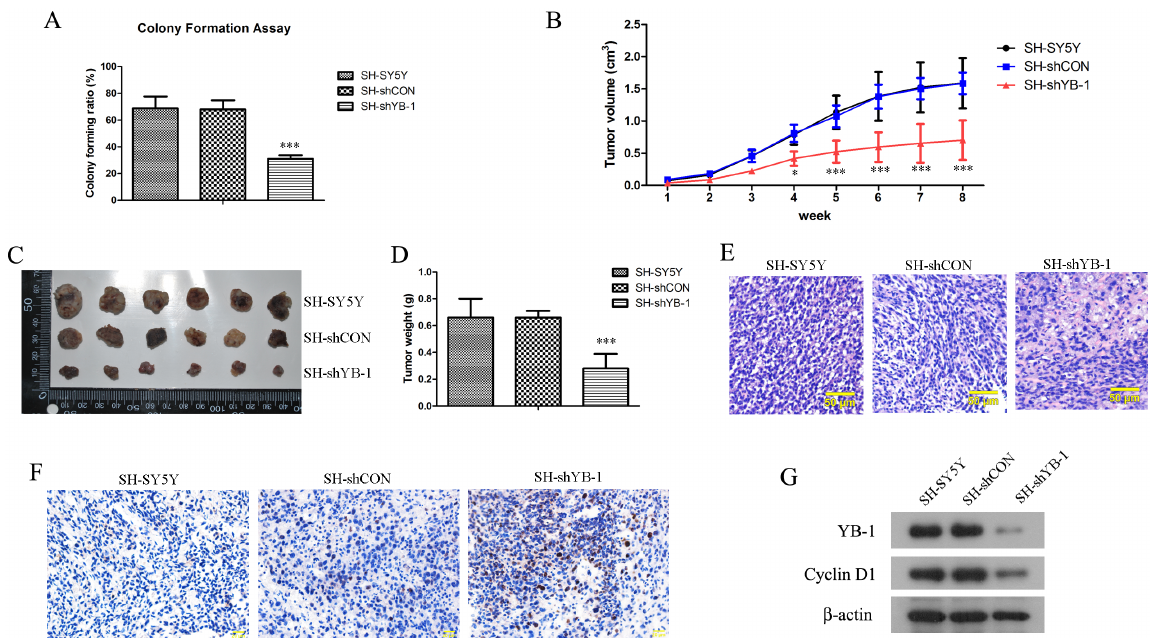
Fig 5. YB-1-silenced SH-SY5Y cells exhibited reduced tumorigenicity and delayed tumor formation in vivo . (A) SH-SY5Y, SH-shCON and SH-shYB-1 cells were seeded sparsely on culture dishes and allowed to form colonies for 2 weeks. Colonies consisting of more than 50 cells were counted and colony forming ratio was calculated. (B) 10 6 SH-SY5Y, SH-shYB-1 or SH-shCON cells were inoculated subcutaneously into an 8-week-old BALB/c nude mouse (n = 6 each group), and tumor volumes were measured externally with a caliper every week and calculated as previously described. (C, D) By end of week 8, the mice were sacrificed, and the tumors were excised, photographed and weighed. (E) Tumor tissues were fixed, paraffin embedded, sectioned and stained with hematoxylin and eosin (H&E) for histological examination. (F) Tumor sections were permeabilized, enzyme inactivated, and incubated sequentially with TUNEL reaction solution, Converter-POD and DAB, followed by counterstaining with hematoxylin. Fragmented DNA was labeled and turned brownish under an optical microscope. (G) Tumor tissues were lysed and total proteins were extracted. Expression levels of YB-1 and Cyclin-D1 in the tumor cells were examined by Western blot analysis. E-G show representative images from all the experimental mice. Values are expressed as mean ± standard deviation. Compared with SH-SY5Y control, * P < 0.05; *** P < 0.001.